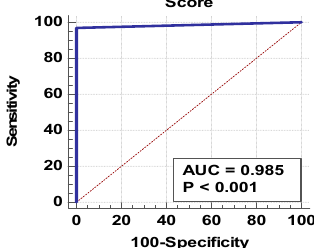
Figure 5. The area under the curve (AUC) attained for VGG19 with SVM-RBF classifier.